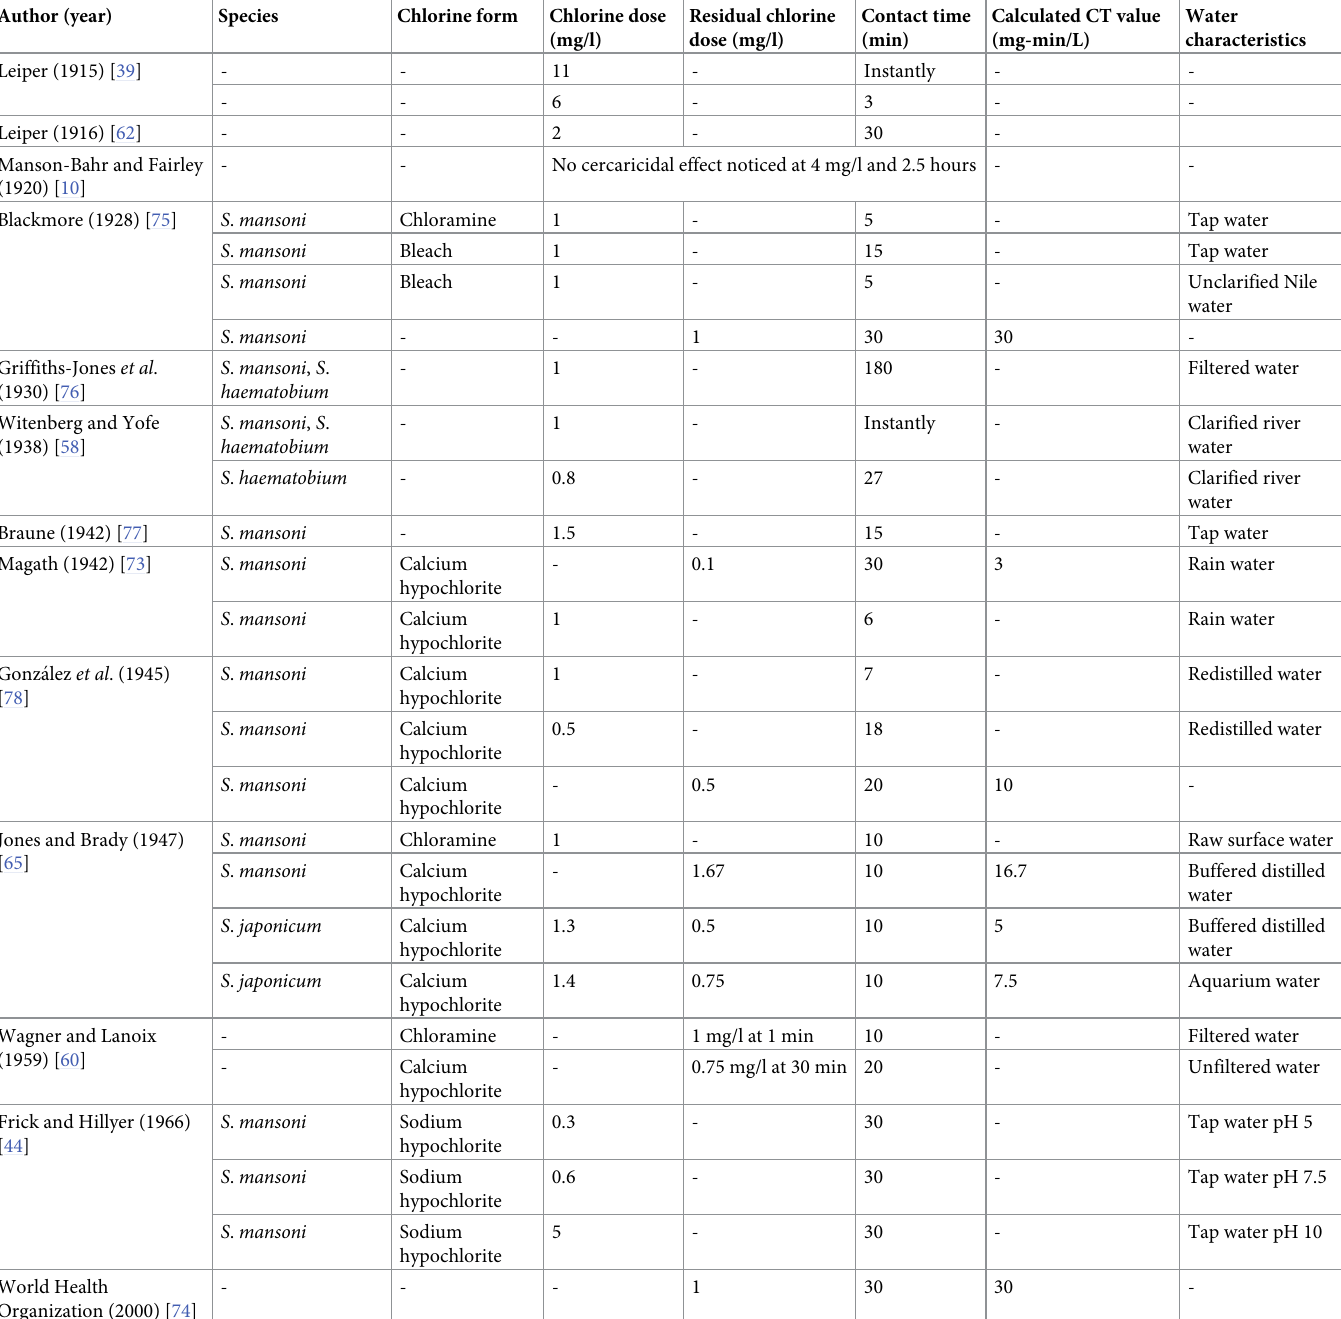
Table 6. Chlorine concentrations and contact times required to kill all schistosome cercariae in water (measured by cessation of movement). Author